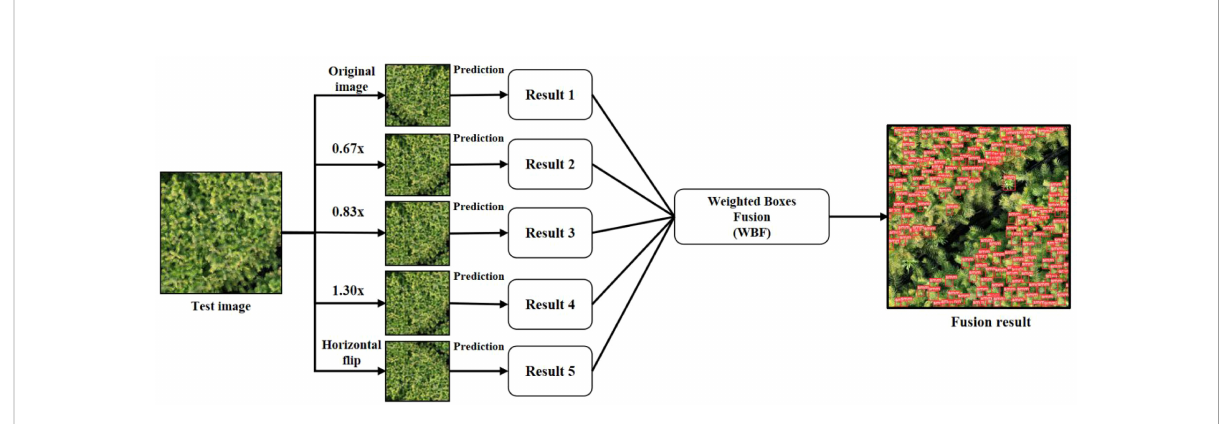
FIGURE 4 Schematic diagram of test time augmentation